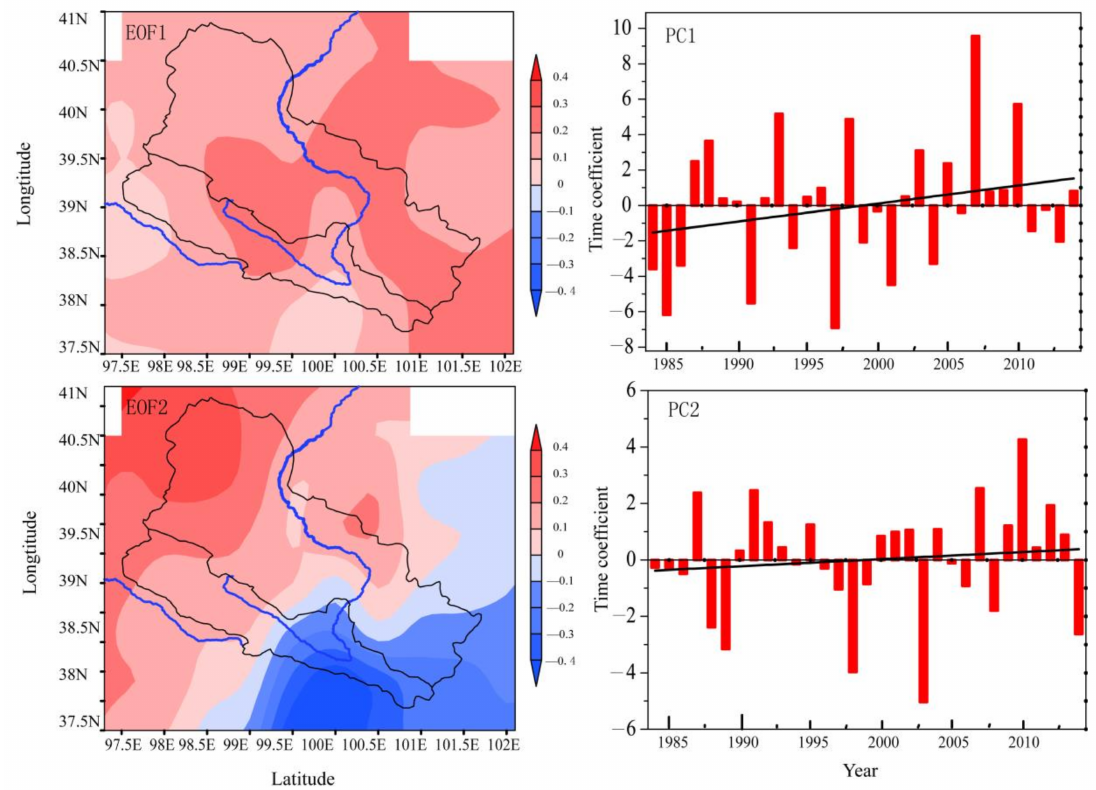
Figure 6. The first two EOFs ( left ) and its time coefficients, i.e., PCs ( right ) for annual precipitation variations from 25 stations in HRB from 1984 to